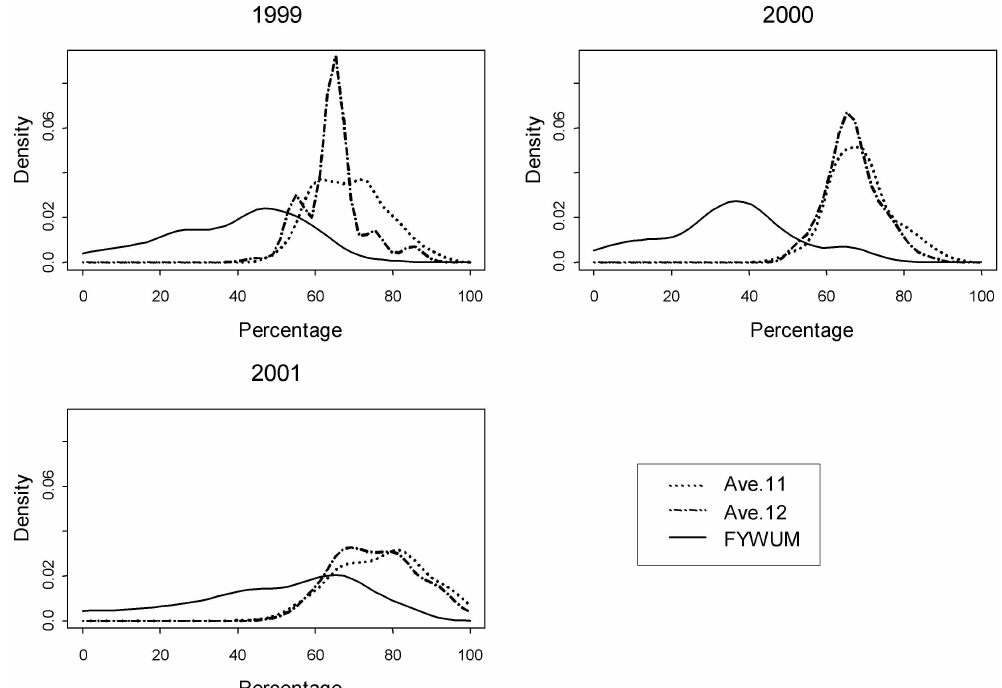
Figure 3: Kernel density estimates of the densities associated with the Grade 11 and Grade 12 mark variables and the FYWUM of the Test Battery 1 data sets for 1999, 2000 and